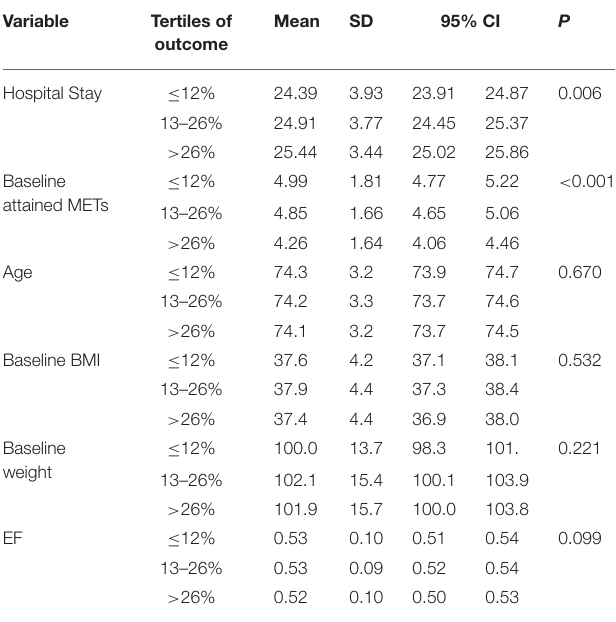
TABLE 3 | Factors influencing the